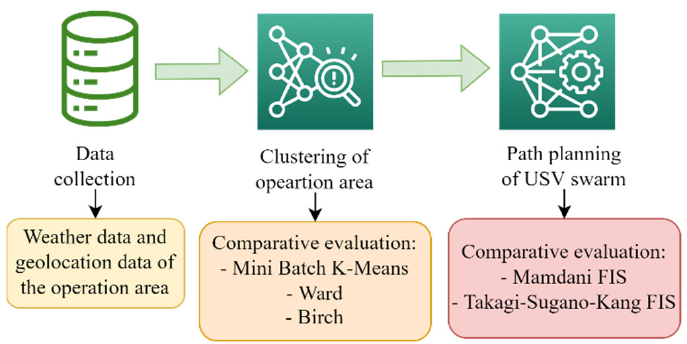
Figure 1. Concept of this study and methodological steps.